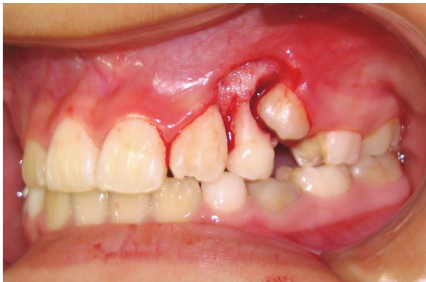
Figure 1: Nodular lesion between the upper left permanent lateral incisor and the primary canine.